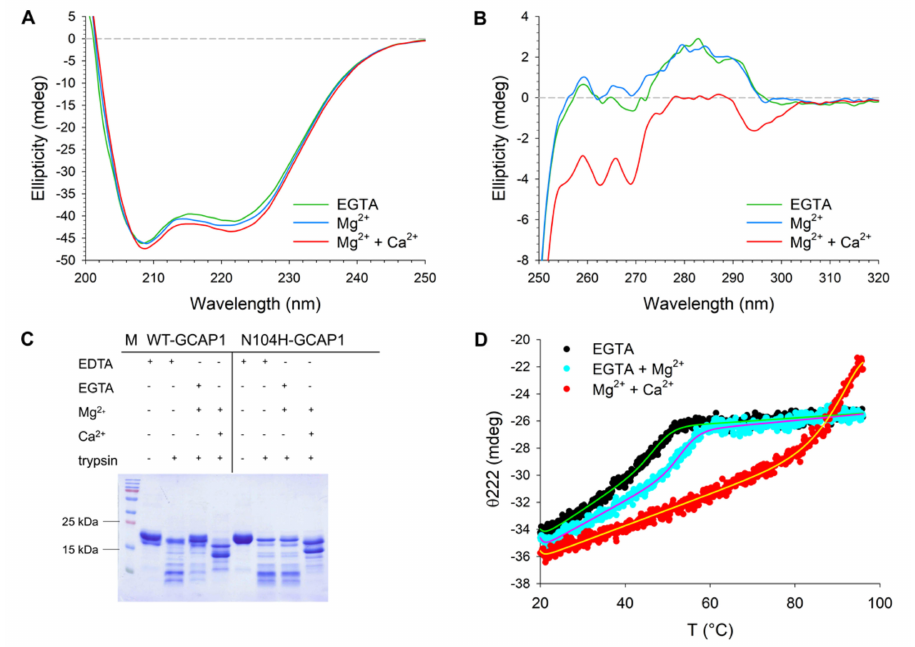
Figure 7. Structural and stability changes occurring in N104H-GCAP1 upon ion binding. ( A ) Far-UV CD spectra of 15 µ M N104H-GCAP1 in the presence of 300 µ M EGTA (green) and after serial additions of 1 mM Mg 2+ (blue) and 300 µ M free Ca 2+ (red). ( B ) Near-UV spectra of ~39 µ M N104H-GCAP1 in the presence of 500 µ M EGTA (green) and after serial additions of 1 mM Mg 2+ (blue) and 500 µ M free Ca 2+ (red). ( C ) Limited proteolysis of 20 µ M WT and N104H-GCAP1 after 10 min incubation with 0.3 µ M trypsin in the presence of 2 mM EDTA, 1 mM EGTA + 1.1 mM Mg 2+ or 1 mM Mg 2+ and 1 mM Ca 2+ . Variants in the presence of 2 mM EDTA and in the absence of trypsin represent the reference MW of the undigested protein. ( D ) Thermal denaturation profiles of 10 µ M N104H-GCAP1 in the presence of 300 µ M EGTA (black), 300 µ M EGTA + 1 mM Mg 2+ (blue) or 1 mM Mg 2+ + 300 µ M Ca 2+ (red). CD spectroscopy measurements were carried out in 20 mM Tris-HCl pH 7.5, 150 mM KCl, 1 mM DTT buffer. Thermal denaturation profiles were collected by monitoring the ellipticity at 222 nm in a temperature range spanning from 20 ◦ C to 96 ◦ C and were fitted to a function accounting for thermodynamic contributions (see Methods